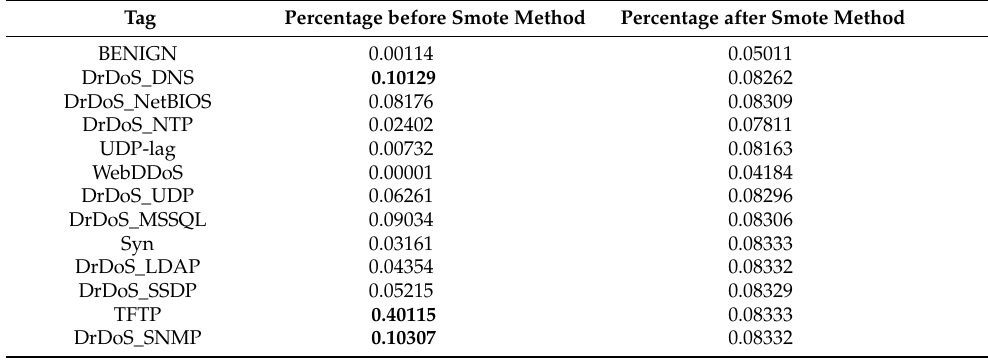
Table 5. Percentage of dataset categories before and after the smote method is